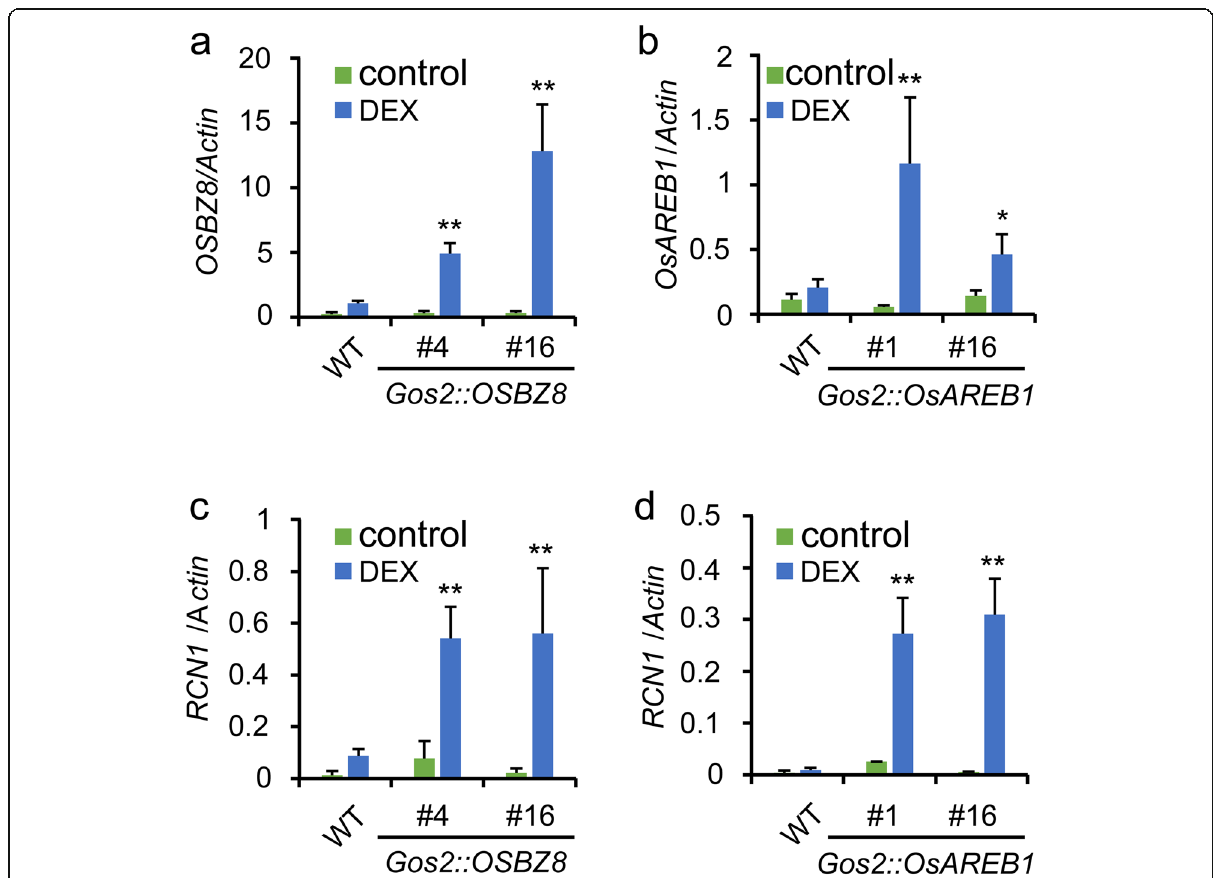
Fig. 4 OsAREB1- and OSBZ8 -induced RCN1 expression. The expression levels of OSBZ8 in Gos2::OSBZ8 ( a ) and Gos2::OsAREB1 ( b ) transgenic plants under DEX treatment. Expression levels of RCN1 in Gos2::OSBZ8 ( c ) and Gos2::OsAREB1 ( d ) transgenic plants under DEX